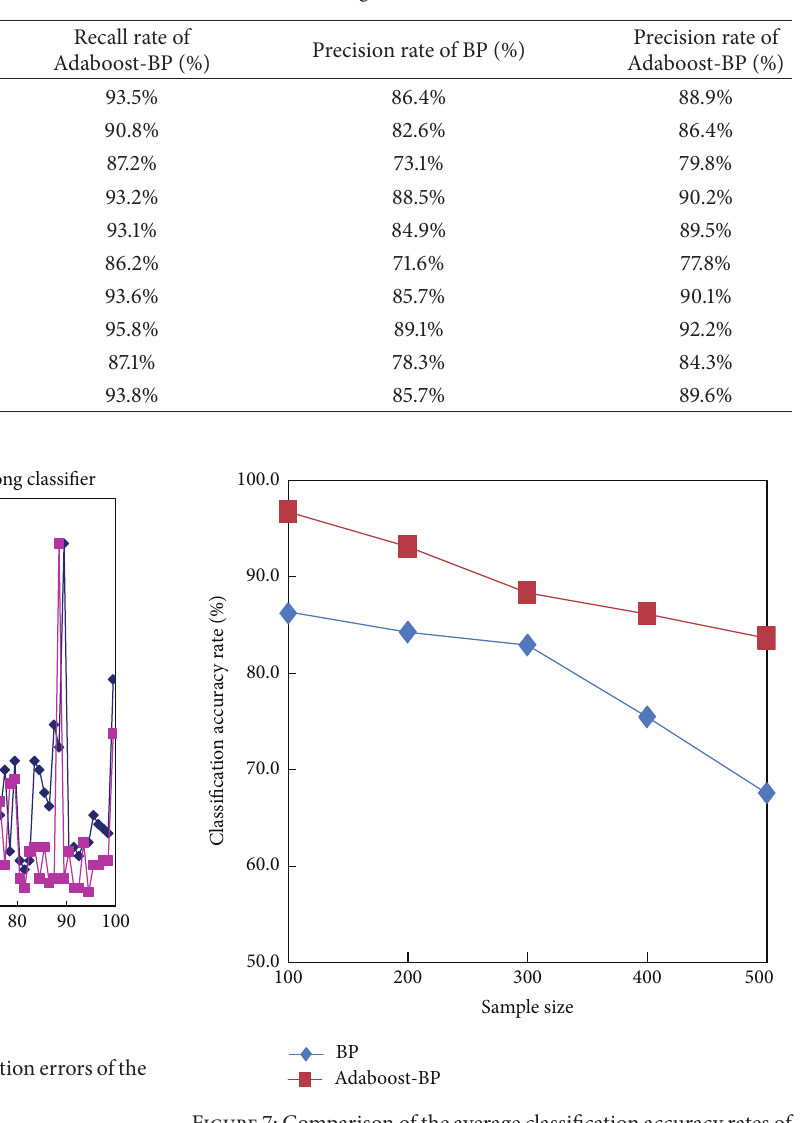
Table 2: Comparison of the experimental results with the results obtained using the BP and Adaboost-BP methods.